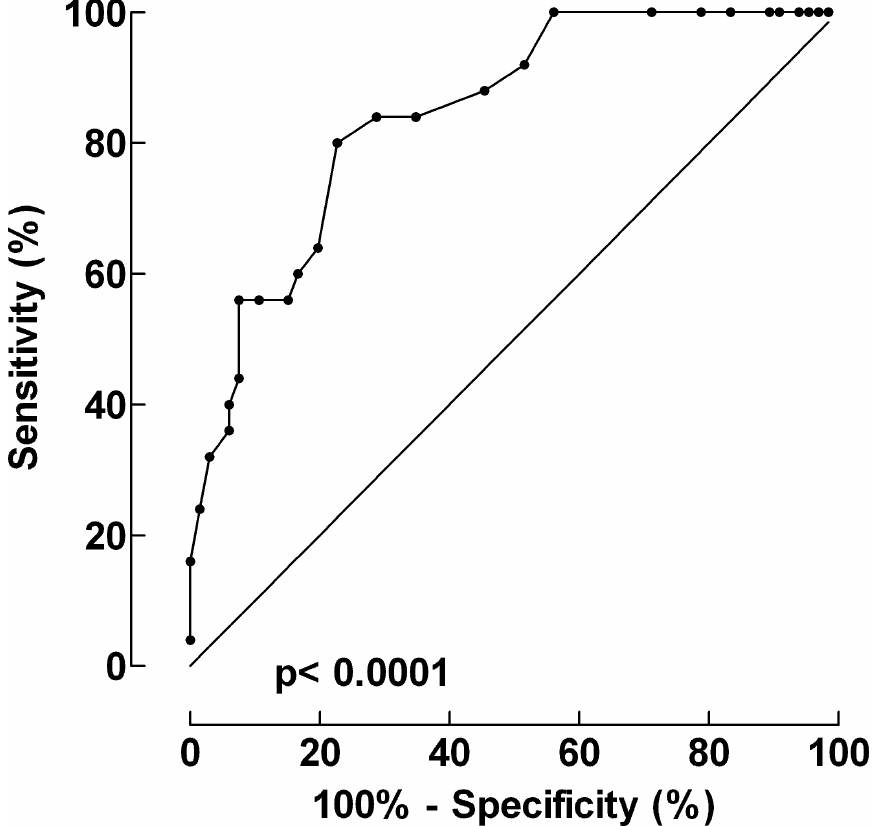
Fig 2. ROC-analysis for the specificity and sensitivity of APACHE-II. ROC = Receivingoperating characteristics. APACHE = Acute physiology and chronichealth evaluation.